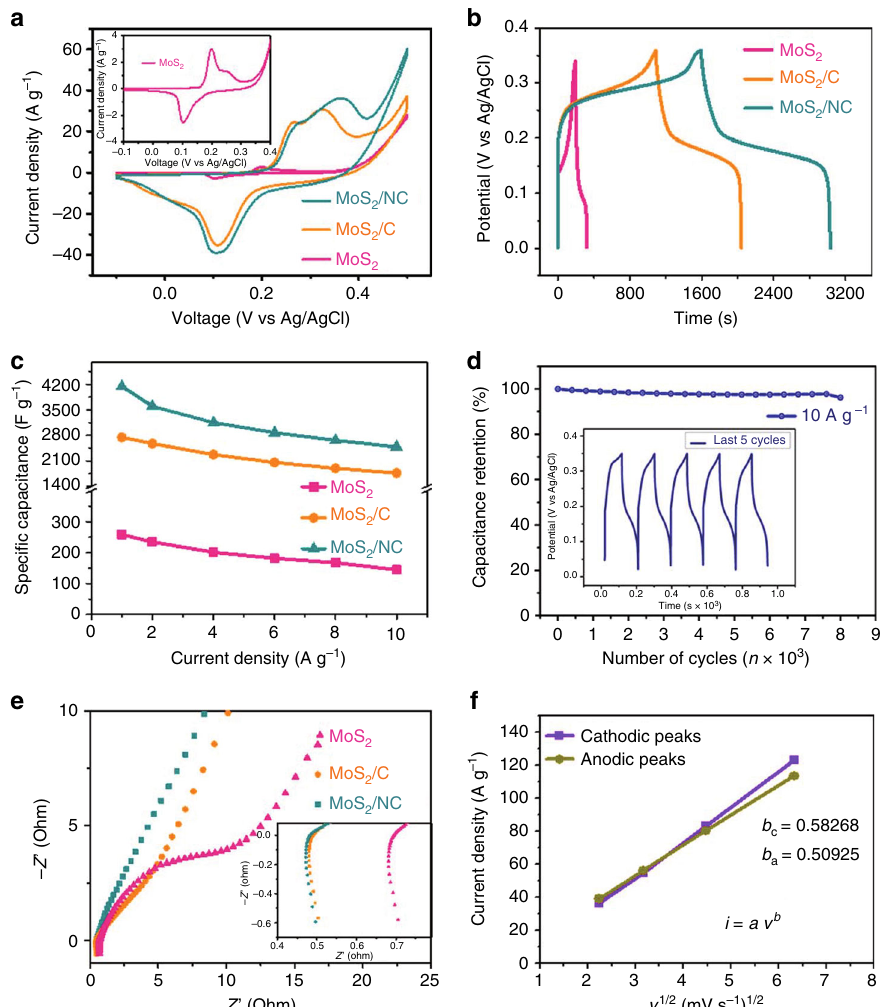
Fig. 4 Electrochemical performance. a – c CV curves at 5 mV s − 1 ( a ), galvanostatic charging – discharging curves at 1 A g − 1 ( b ), and speci fi c capacitances at different current densities from 1 to 10 A g − 1 ( c ) of MoS 2 nanosheets, and the MoS 2 /C and MoS 2 /NC heteroaerogels. d Cycling performance at a current density of 10 A g − 1 of the MoS 2 /NC heteroaerogel. The inset in ( d ) shows charging – discharging curves of the last 5 cycles. e Nyquist plots of the three electrodes. f Dependence of the peak current density on square root of sweep rate of the MoS 2 /NC the conditions investigated was both diffusion- and surface- are both the lowest among the three electrodes (Fig. 4e and the controlled, demonstrating a combined PC energy storage inset), suggesting the excellent conductivity and compatible contributed from battery-like ion intercalation reactions and fast electrode – electrolyte interface. The Nyquist plots demonstrated a surface redox reactions. Since the b -values are closer to 0.5, the conspicuously decreased R ct for the MoS 2 -based heteroaerogels, compared with the pure MoS 2 . The enhanced capability of charge diffusion-controlled ion intercalation effect may be predominant transfer should be ascribed to the graphitized carbon inserting in the whole PC energy storage process, which is facilitated by into MoS 2 interlayers and coating on the surfaces of MoS 2 interlayer distance expansion of the MoS 2 /NC heteroaerogel that nanosheets, which ensures the effective electron transfer between allows ef fi cient ion diffusion into/from the interlayers. nanosheets in the composite heteroaerogels during capacitive process. X-ray photoelectron spectroscopy analyses . In order to probe Kinetics analysis of the MoS 2 /NC heteroaerogel electrode was conducted based on their CV curves shown in Supplementary the interfacial interactions between MoS 2 and carbon-based (C or NC) components, X-ray photoelectron spectroscopy (XPS) Fig. 19a. From the plots of peak current density ( I p ) versus square root of sweep rate ( ν 1/2 ) from 2 to 40 mV s − 1 for both cathodic and anodic peaks (Fig. 4f), the current follows well a power-law relationship with the sweep rate ( I p = a ν b ). A b -value of 0.5 indicates that the current is controlled by semi-in fi nite linear diffusion, whereas a value of 1 indicates that the current is surface-controlled. Speci fi cally, the b -value was calculated to be ~0.58 and ~0.51 from the cathodic peak and anodic peak, respectively. The result indicates that the electrode kinetics under